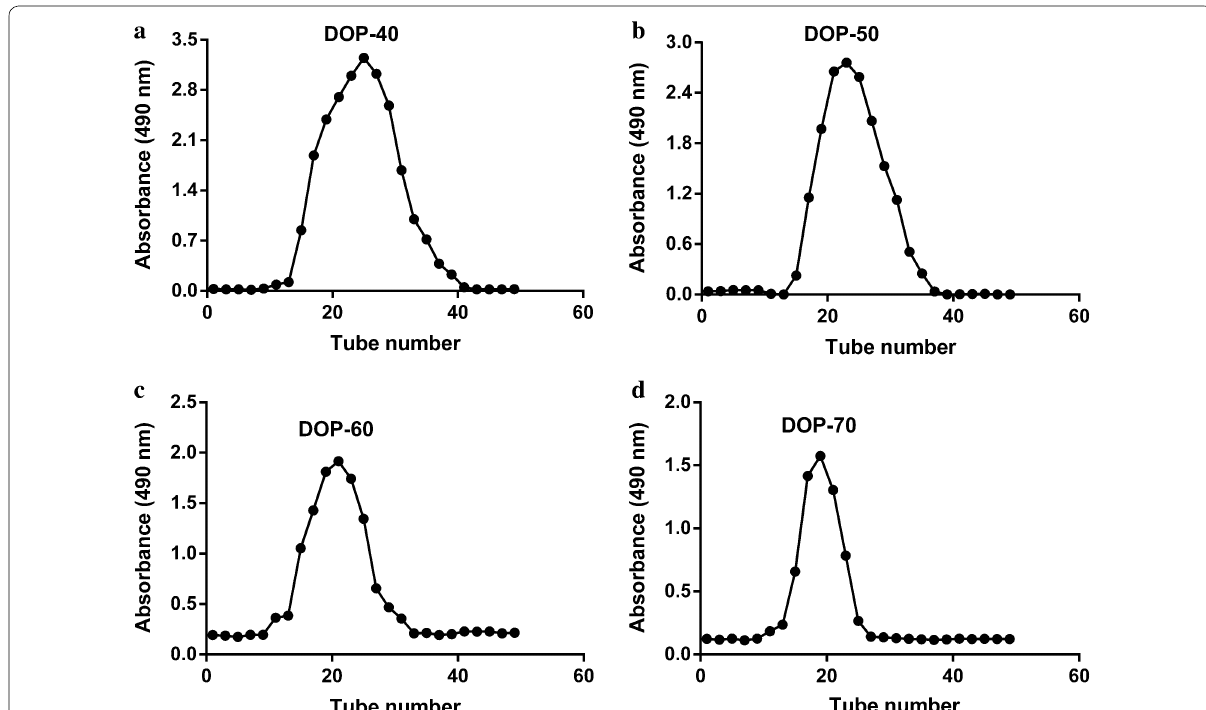
Fig. 4 HPLC profile of mixed monosaccharide standards (1-mannose, 2-rhamnose, 3-galactose, 4-glucose, and 5-arabinose), DOP-40, DOP-50, DOP-60, and